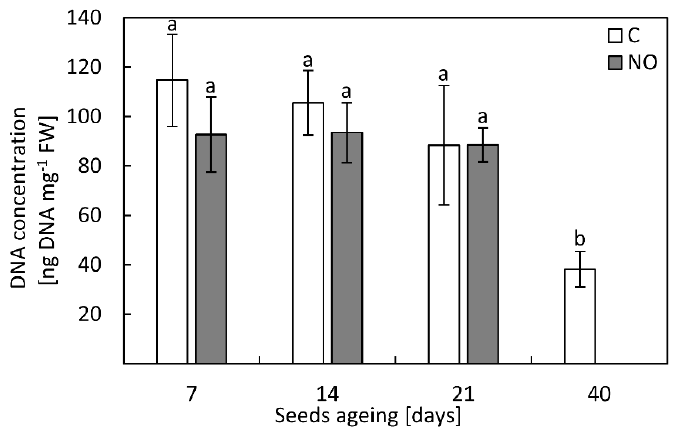
Figure 4. The DNA concentration in the axes of apple embryos isolated from seeds subjected to accelerated ageing for 7, 14, 21 and 40 days (C) or isolated from aged seeds and treated with NO (NO). Values are average ±SD of 3–4 independent repetitions. Different letters indicate significant differences determined by Tukey’s test ( p < 0.05).